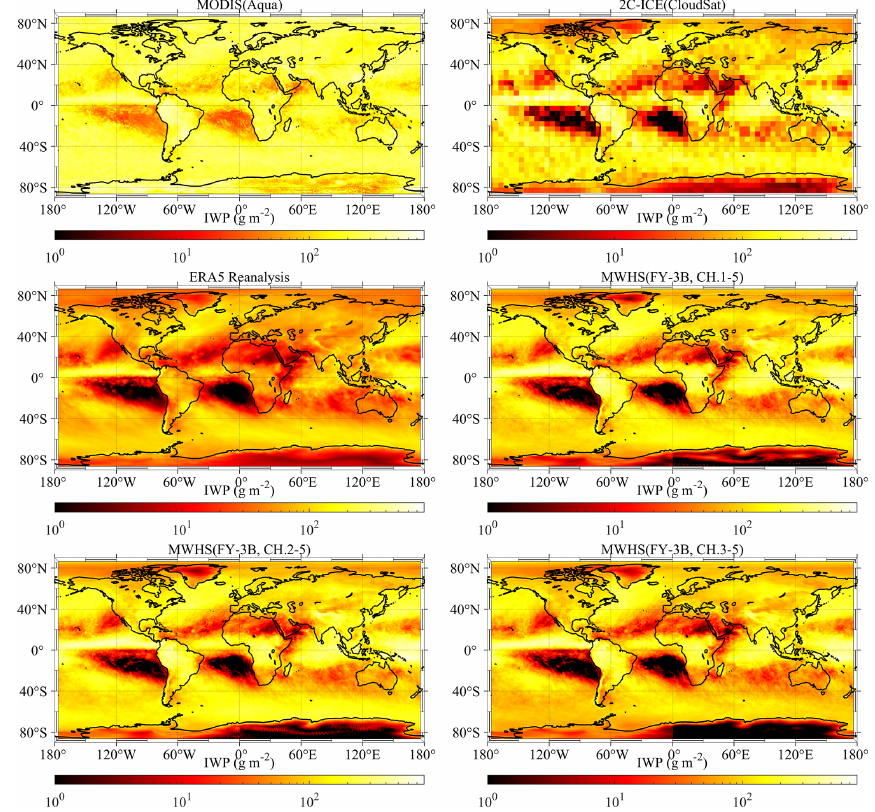
Figure 14. Global mean IWP maps for 2015 from MODIS, 2C-ICE, ERA5, and different channel combinations from MWHS. The 2C-ICE is gridded on a 5 ◦ grid, while the other products are gridded on a 1 ◦ grid.